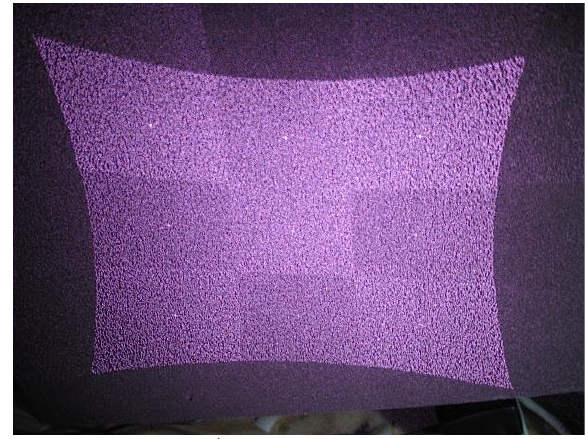
Figure 4 - Kinect Light Coding